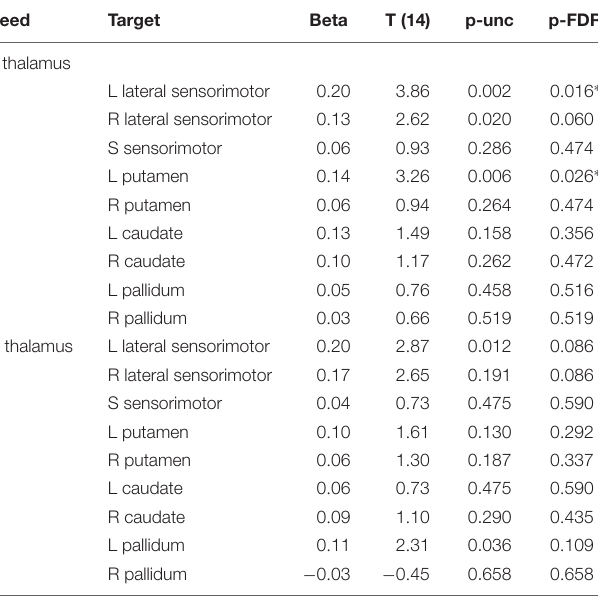
TABLE 2 | Region-of-Interest to Region-of-Interest analysis.